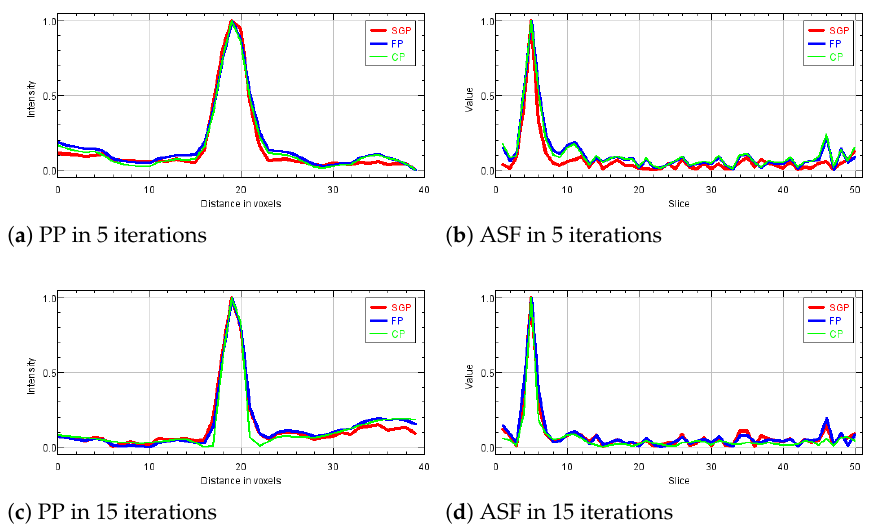
Figure 4. Plots of the Plane Profile on the left and of the Artifact Spread Function (ASF) vectors on the right, taken over one microcalcification of cluster number 3 in BR3D phantom obtained. In all the plots the red line corresponds to SGP method, the blue line to FP method and the green line to CP